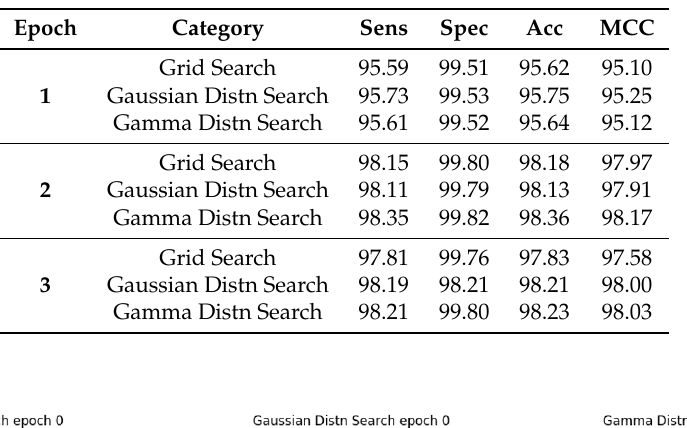
Table 4. Comparison of random search, Gaussian distribution search, and Gamma distribution search